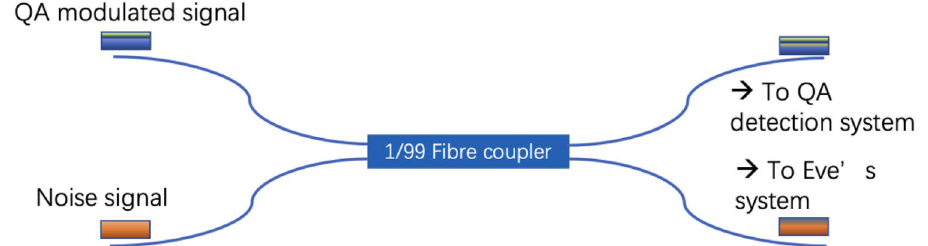
Figure 5. Implementation of the correlated jamming attack via an optical fibre